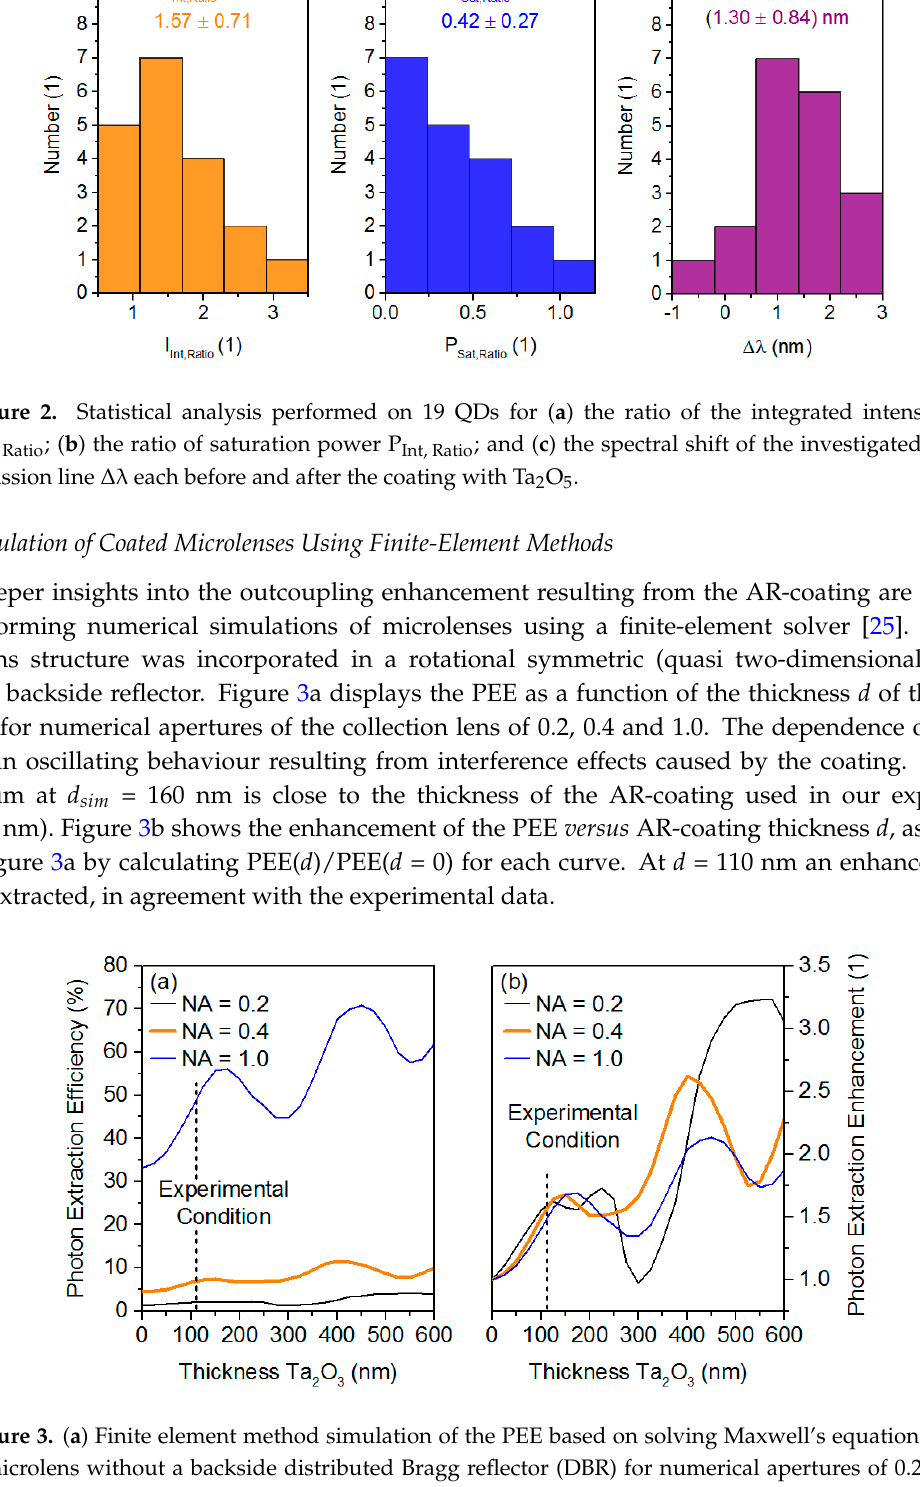
Figure 2. Statistical analysis performed on 19 QDs for ( a ) the ratio of the integrated intensities I (cid:2893)(cid:2924)(cid:2930),(cid:2902)(cid:2911)(cid:2930)(cid:2919)(cid:2925) ; ( b ) the ratio of saturation power P (cid:2893)(cid:2924)(cid:2930),(cid:2902)(cid:2911)(cid:2930)(cid:2919)(cid:2925) ; and ( c ) the spectral shift of the investigated QD emission line Δλ each before and after the coating with Ta 2 O 5 .